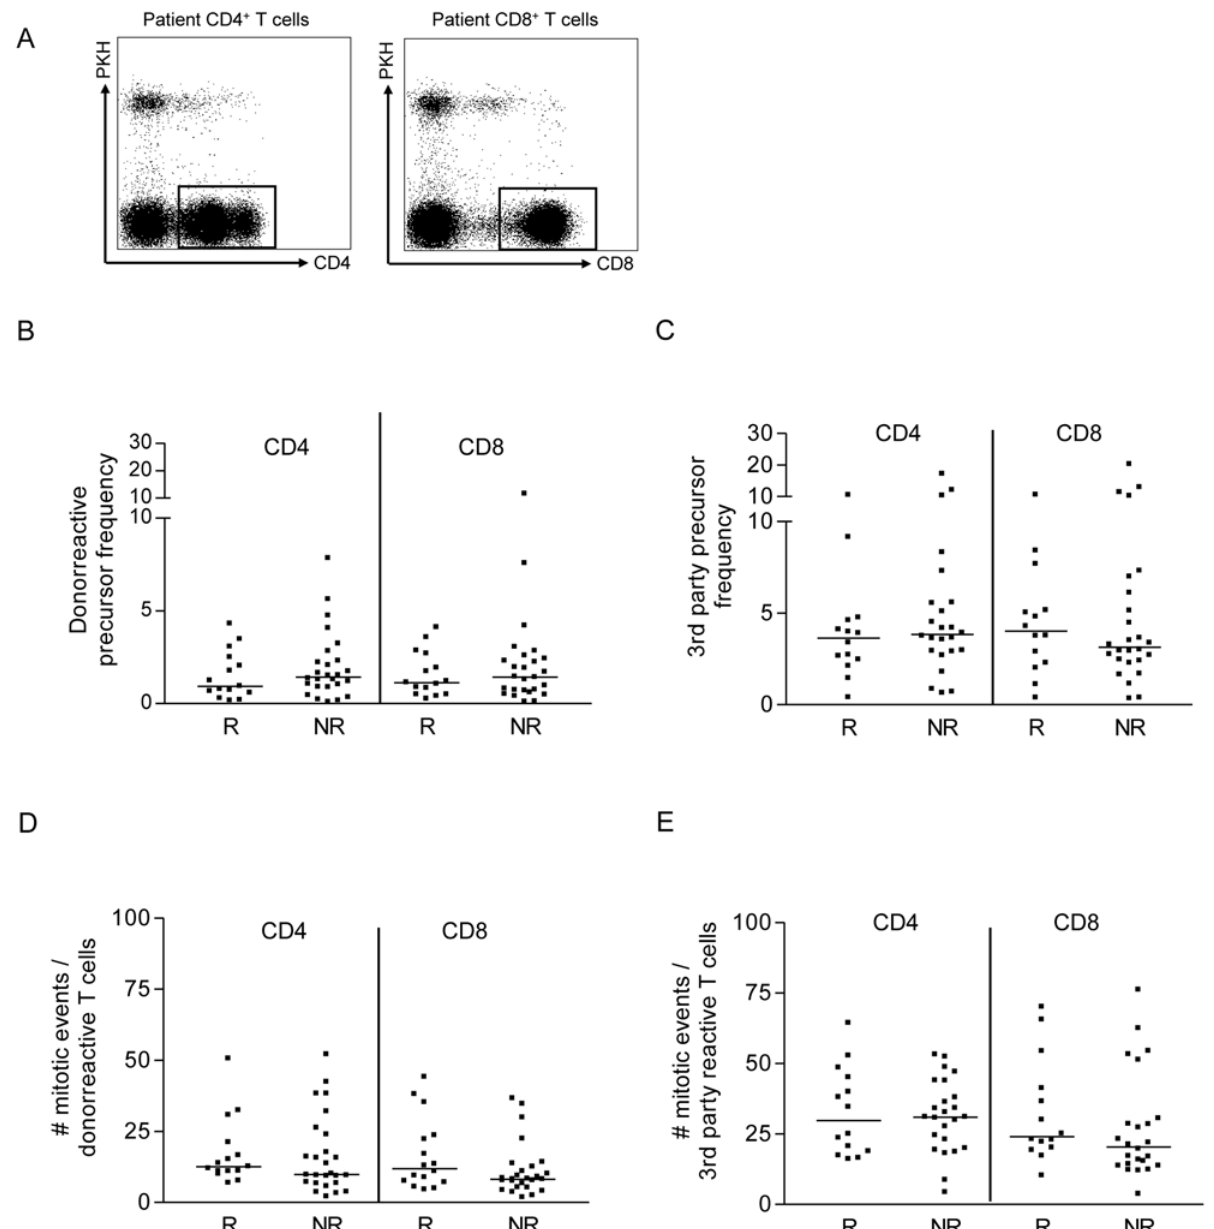
Figure 2. The functional capacity of allo- and 3 rd party-reactive CD4 + and CD8 + T cells and CD4 + CD25 high regulatory T cells isolated from the peripheral blood of transplant patients immediately before the start of tacrolimus dose reduction (T1). A CFSE-MLR was used to determine the precursor frequency and mitotic events of alloreactive CD4 + (left) and CD8 + (right) T cells. CFSE labeled patient PBMC (1*10 5 ) were stimulated with PKH labeled donor or 3 rd party cells (1*10 5 ) for 6 days. Using flow cytometry, patient T cells were gated based on forward/side scatter and PKH exclusion and subsequent CD4 and CD8 staining. An example is shown in (A). The precursor frequency and mitotic events of alloreactive CD4 + and CD8 + T cells were calculated on the basis of the CFSE dilution pattern using Modfit LT TM software [22]. (B) The precursor frequency of donor reactive CD4 + and CD8 + T cells. (C) The precursor frequency of 3 rd party reactive CD4 + and CD8 + T cells. (D) The number of mitotic events of alloreactive CD4 + and CD8 + T cells. (E) The number of mitotic events of 3 rd party reactive T cells. R vs. NR=not significant. doi:10.1371/journal.pone.0002711.g002 validated expansion protocol [21]. Treg of each transplant patient Changes in the distribution of effector and memory T cell showed potent ability to suppress both anti-donor and anti-3 rd -party subsets over time responses. Considerable variation was observed in the suppressive Having established a difference in the ratio between memory potential of Treg between individual patients, but overall no and Treg before the reduction of tacrolimus (T1), we wondered differences were observed between rejectors and non-rejectors whether changes over time would provide additional information. (Figure 3). The expanded CD4 + CD25- control T cells did not Analysis of the immunological markers before transplantation reveal suppressive capacity in any of the patients (data not shown). (T0), showed no differences between rejectors and non-rejectors.